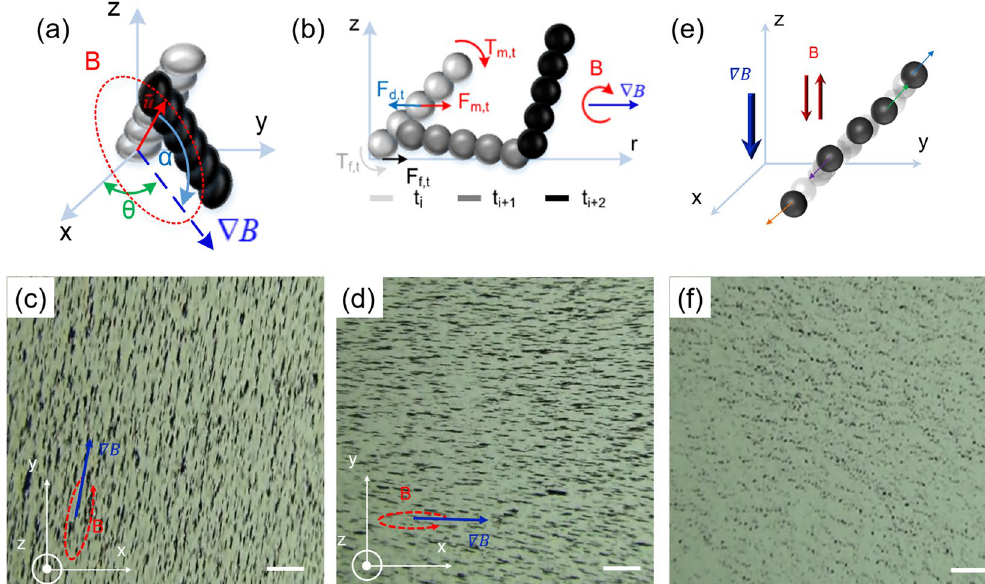
Figure 4. Enhanced tumbling motion of nanoparticles. ( a ) Three-dimensional schematic of magnetic field and gradient field applied to generate enhanced tumbling motion. ( b ) Two-dimensional force and torque exerted on particle chains in proposed locomotion method. ( c,d ) Captured images of particles chains using proposed method in two different control orientations. ( e ) Disaggregation mechanism of particle chain. ( f ) Combination of perpendicular alternative field and gradient field breaks chain structure by chain–chain and dipole–dipole repulsion as illustrated by captured image ( f ). Scale bars: 500